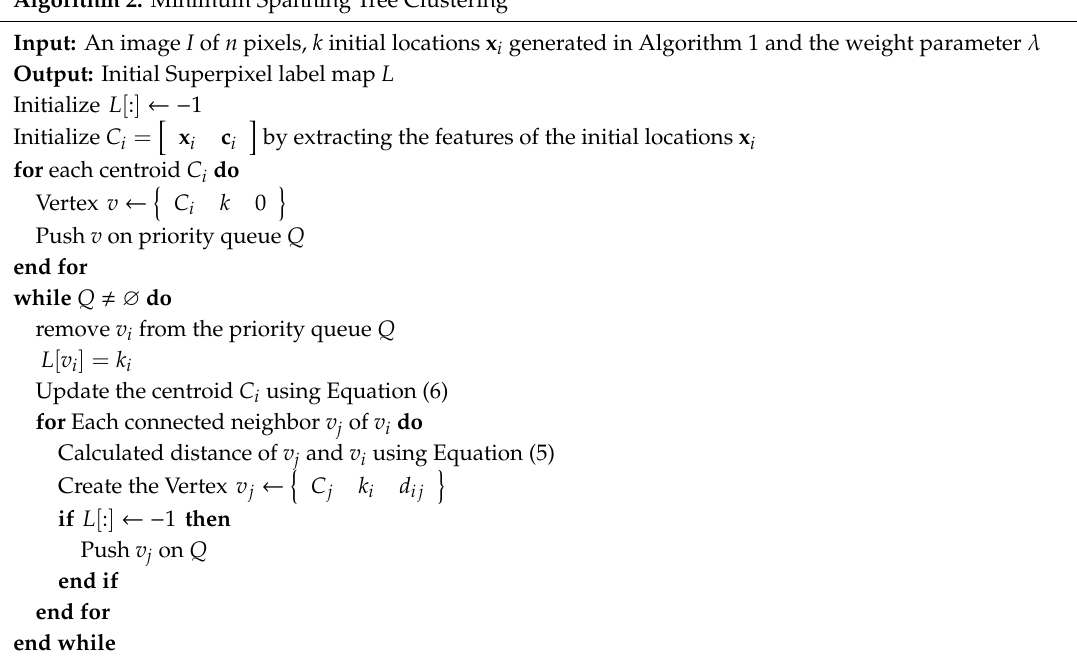
Algorithm 2. Minimum Spanning Tree